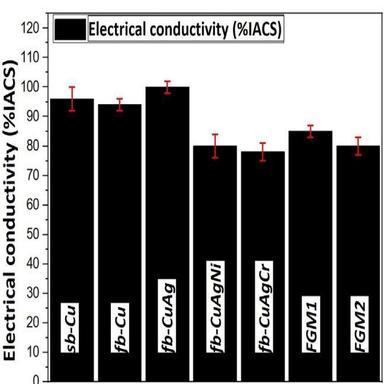
The electrical conductivity values of bulk materials.